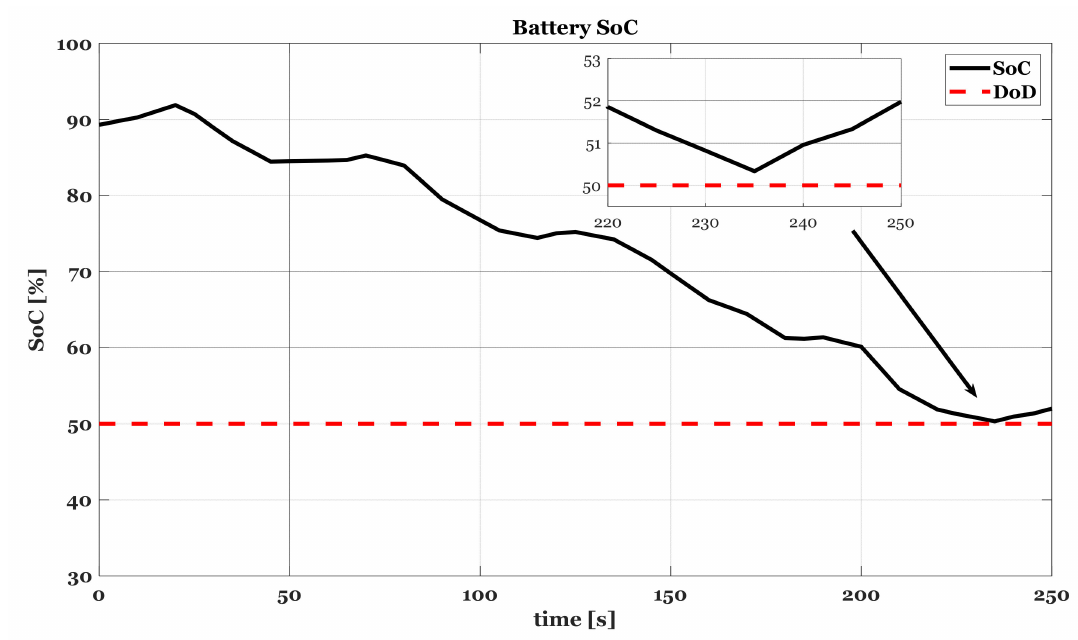
Figure 18. Battery SoC during the load cycle based on the new sizing procedure.